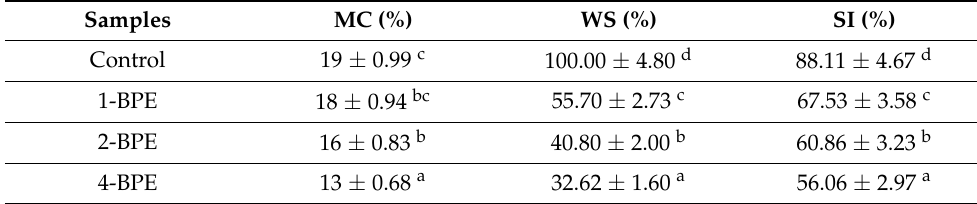
Table 2. Physical characterization of